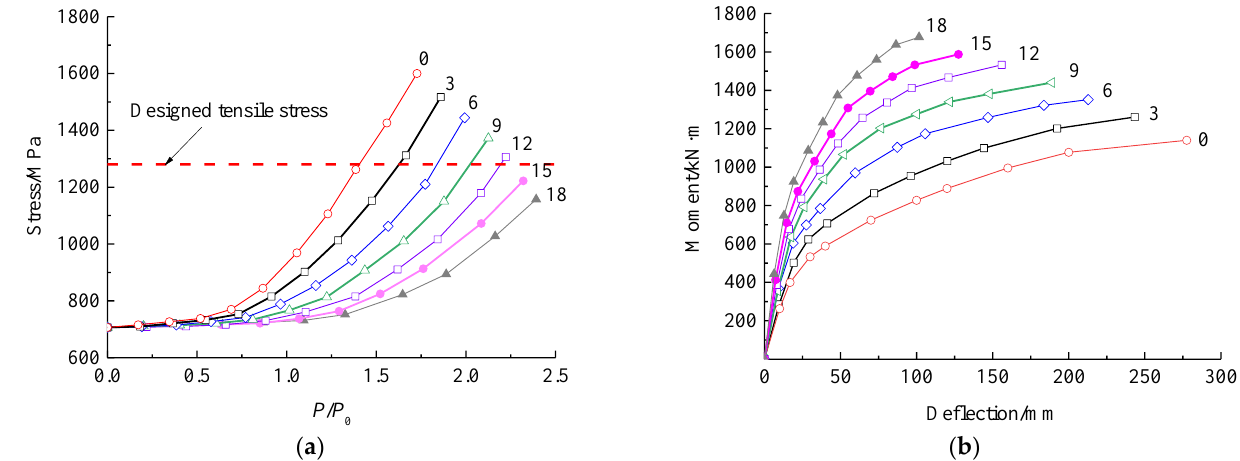
Figure 19. Effect of the amounts of prestressed CFRP plates on: ( a ) the stress of prestressed steel wire; ( b ) mid-span deflection.